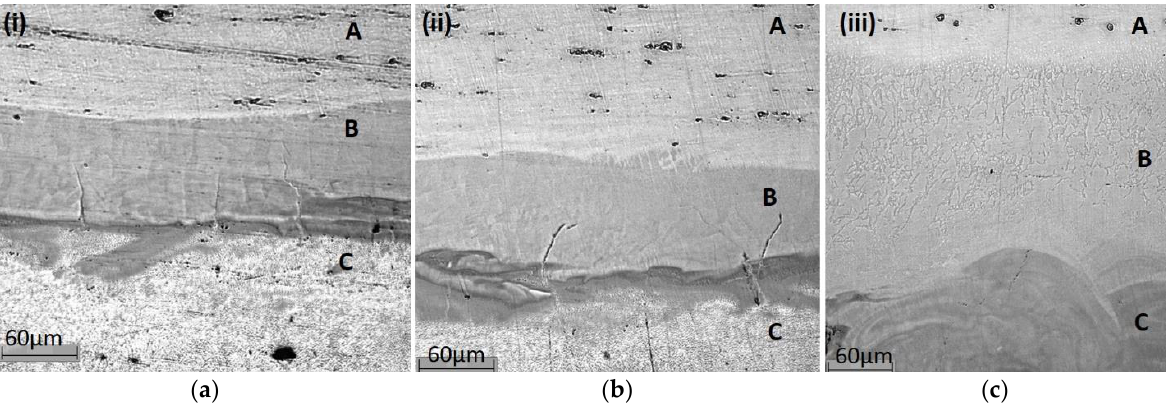
Figure 3. The area of the SS304L/AlSi10Mg interface with cracks when constructing an FBM by the SLM method with a various energy density of the laser beam: ( a ) 105 J/mm 3 , ( b ) 147 J/mm 3 , ( c ) 737 J/mm 3 (A is the SS304L, B is the thermally stressed interface area, С is the AlSi10Mg) [23].